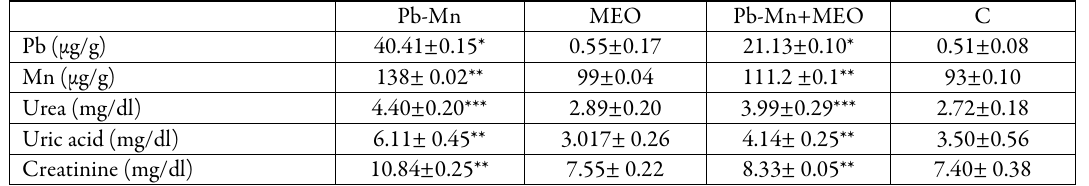
Table 2. Effect of the essential oil of the M. spicata plant on the various biochemical parameters in rats intoxicated by Pb-Mn compared to control rats Pb-Mn MEO Pb-Mn+MEO C Pb (µg/g) 40.41±0.15* 0.55±0.17 21.13±0.10* 0.51±0.08 Mn (µg/g) 138± 0.02** 99±0.04 111.2 ±0.1** 93±0.10 Urea (mg/dl) 4.40±0.20*** 2.89±0.20 3.99±0.29*** 2.72±0.18 Uric acid (mg/dl) 6.11± 0.45** 3.017± 0.26 4.14± 0.25** 3.50±0.56 10.84±0.25** 7.55± 0.22